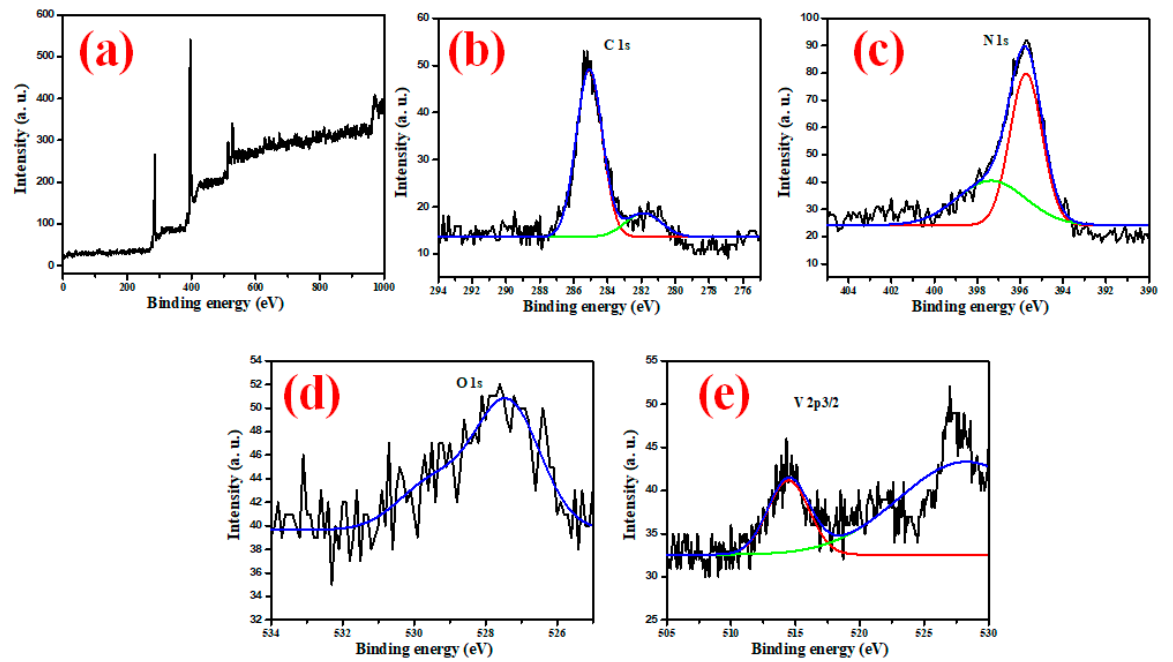
Figure 3. ( a ) XPS spectrum of the V 2 O 5 -g-C 3 N 4 nanosorbent, and XPS spectra survey of ( b ) C 1s, ( c ) N 1s, ( d ) O1s and ( e ) V 2p3/2 for the V 2 O 5 -g-C 3 N 4 nanosorbent.